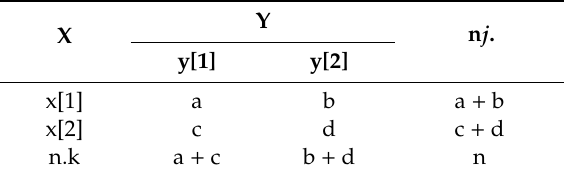
Table 1. Four-fold contingency table (Bud í kov á et al.